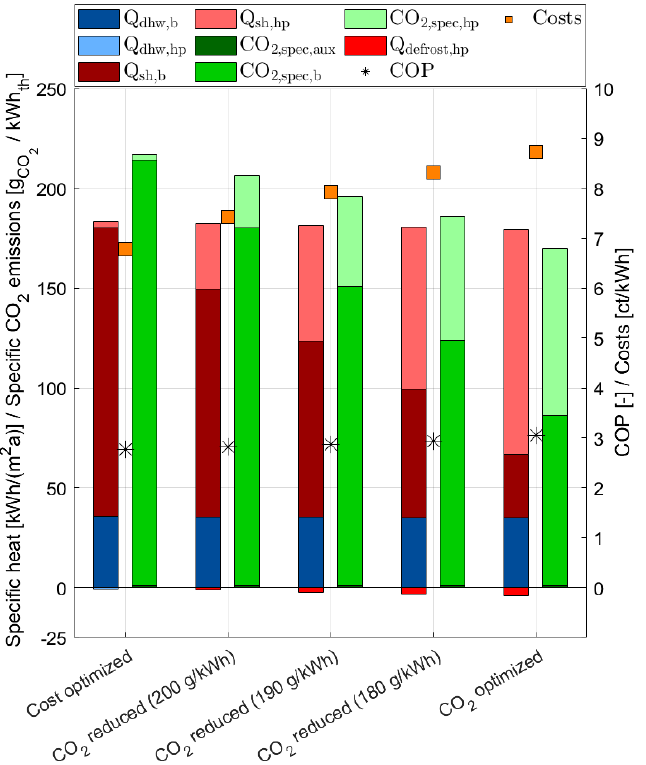
Figure 24. Comparison of a cost and CO 2 -optimized strategy with different specific CO 2 emission set points of the newly developed algorithm and a household electricity tariff. Table 8. Performance indicators of different operation strategies with household and heat pump electricity